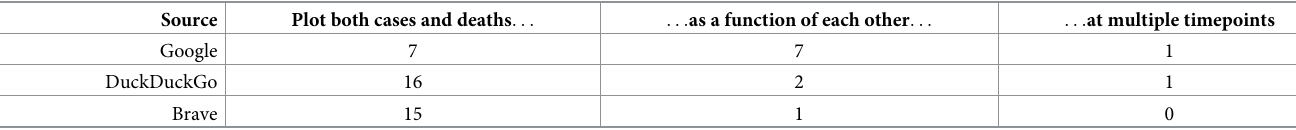
Table 1. Images of COVID-19 deaths vs. cases over time, various search engines. Source Plot both cases and deaths ...